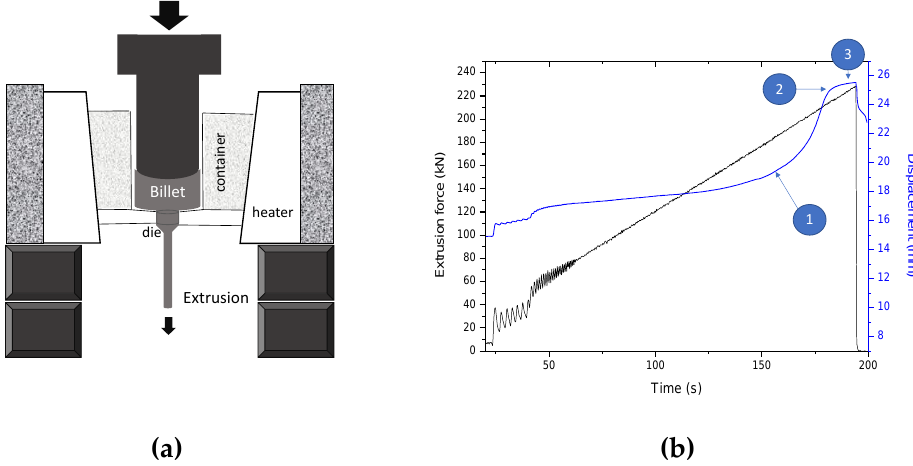
Figure 1. ( a ) Schematic representation of the direct extrusion process. ( b ) Displacement and extrusion force vs. time graphs for hot extrusion processing of aluminium compact. The black line represents the extrusion force versus time. The initial oscillations indicate the friction forces inside the equipment as the material is expelled. The extrusion force increases with time until the end of the test. For typical curves of direct extrusion, the evolution of the displacement with time (Figure 1b Blue line) presents different stages: (1) the force increases in a non-linear way, (2) full densification is achieved, and (3) the force reaches a stationary value or decreases slightly [9]. From these curves, two important parameters of the extrusion process are obtained: (1) the time from the beginning of the applied force to the final extrusion process, and (2) the maximum applied force needed when the displacement reaches a stationary value. Other information, such as friction force, can be obtained from these curves, in case sticking occurs at the container wall. The extrusion ratio (R) is a fixed parameter of the extrusion process. It can be defined as R = A 0 /A f , where A o is the cross-sectional area of the initial billet, and A f is the cross-sectional area of the final product.